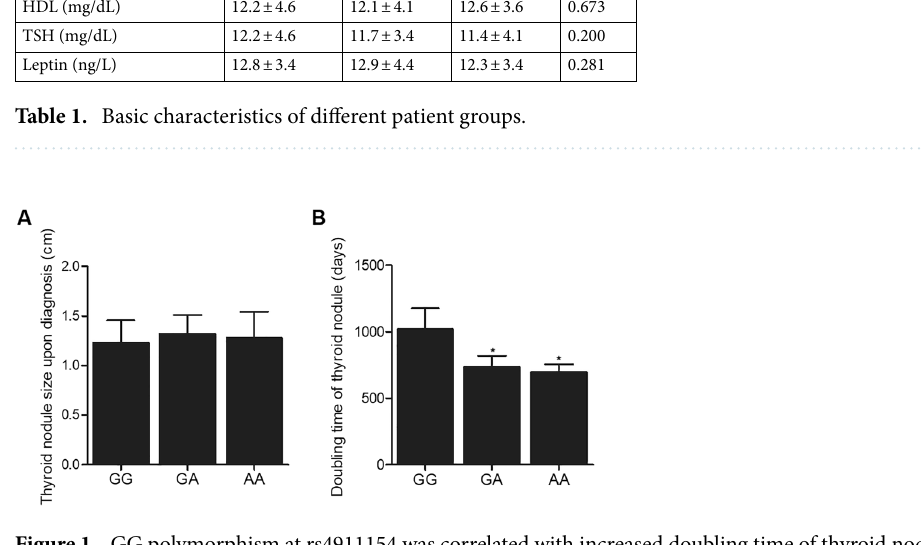
Figure 1. GG polymorphism at rs4911154 was correlated with increased doubling time of thyroid nodules (*P value < 0.05 vs. GG group). (A) No obvious difference was observed in the size of thyroid nodules in patients carrying different genotypes at rs4911154. (B) The doubling time of thyroid nodule was increased in patients carrying GG alleles when compared with patients carrying GA and AA alleles.